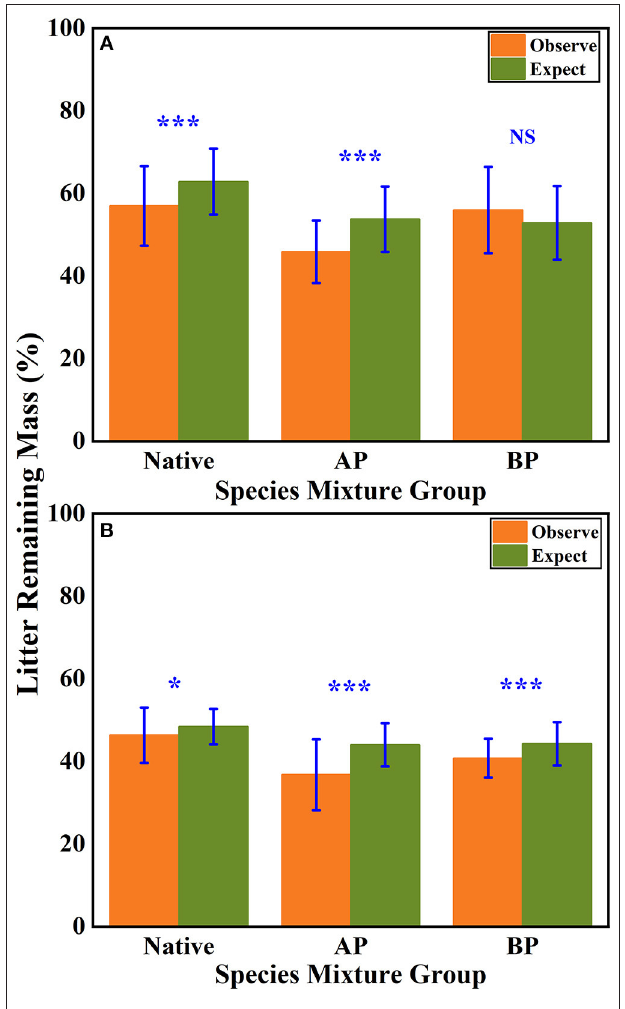
FIGURE 5 | The results of the paired t-test show the litter’s remaining mass rate at observed and expected values for the hydro-fluctuation zone (A) and terrestrial zone (B) . The Ap-group indicates litter mixtures of A. philoxeroides and native species, and the Bp-group represents litter mixtures of B. pilosa and native species. All data are presented as mean ± standard deviation. A paired t -test was used to test for significant differences between observed